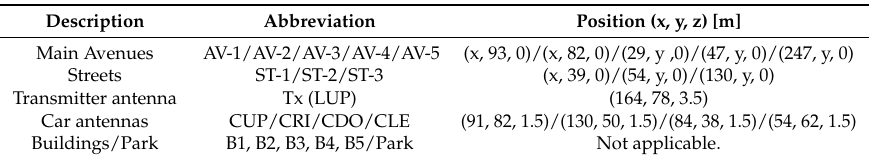
Table 2. Simulation parameters.